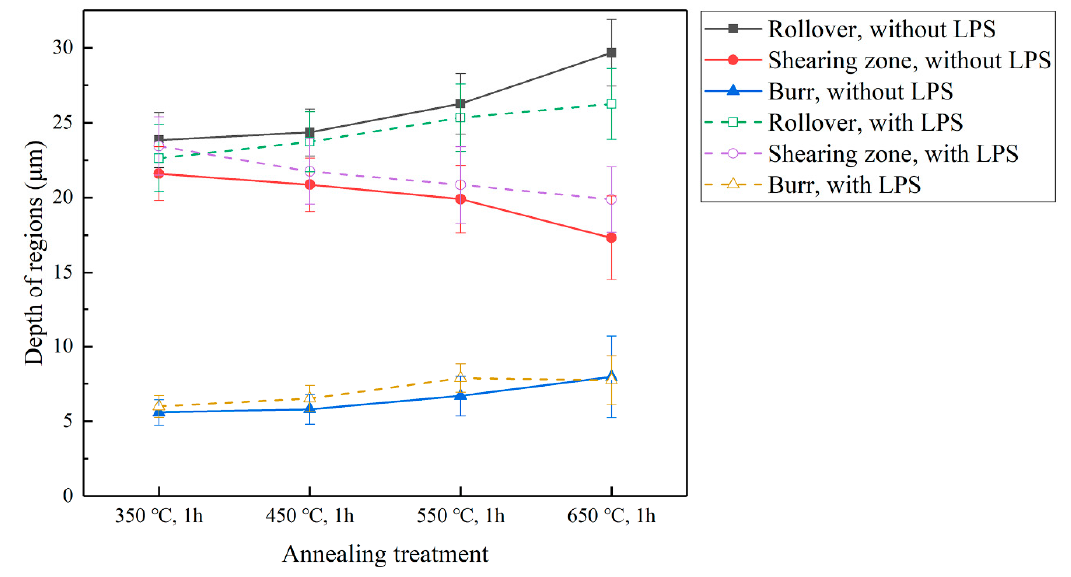
Figure 13. Influence of the initial grain size on the depth of di ff erent regions of punched parts with and without LPS under a laser energy density of 38.2 J / cm 2